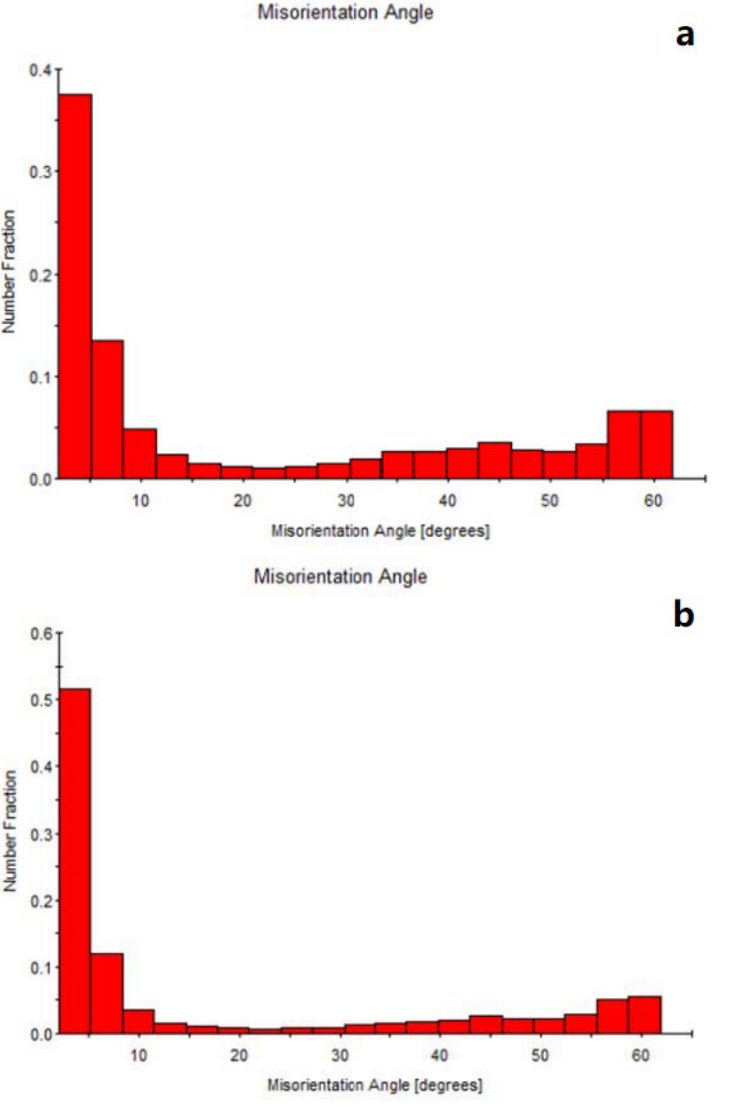
Figure 17. Misorientation angle for: ( a ) 𝑇 11 ; ( b ) 𝑇 31 .